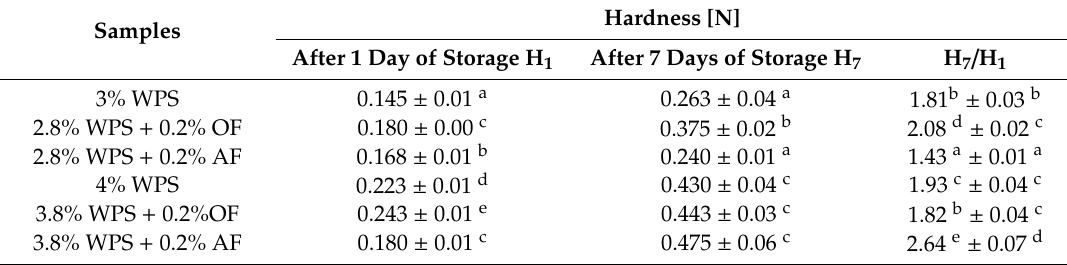
Table 4. Gel hardness (N) of waxy potato starch and its mixtures with plant fiber measured after 1 day and 7 days of